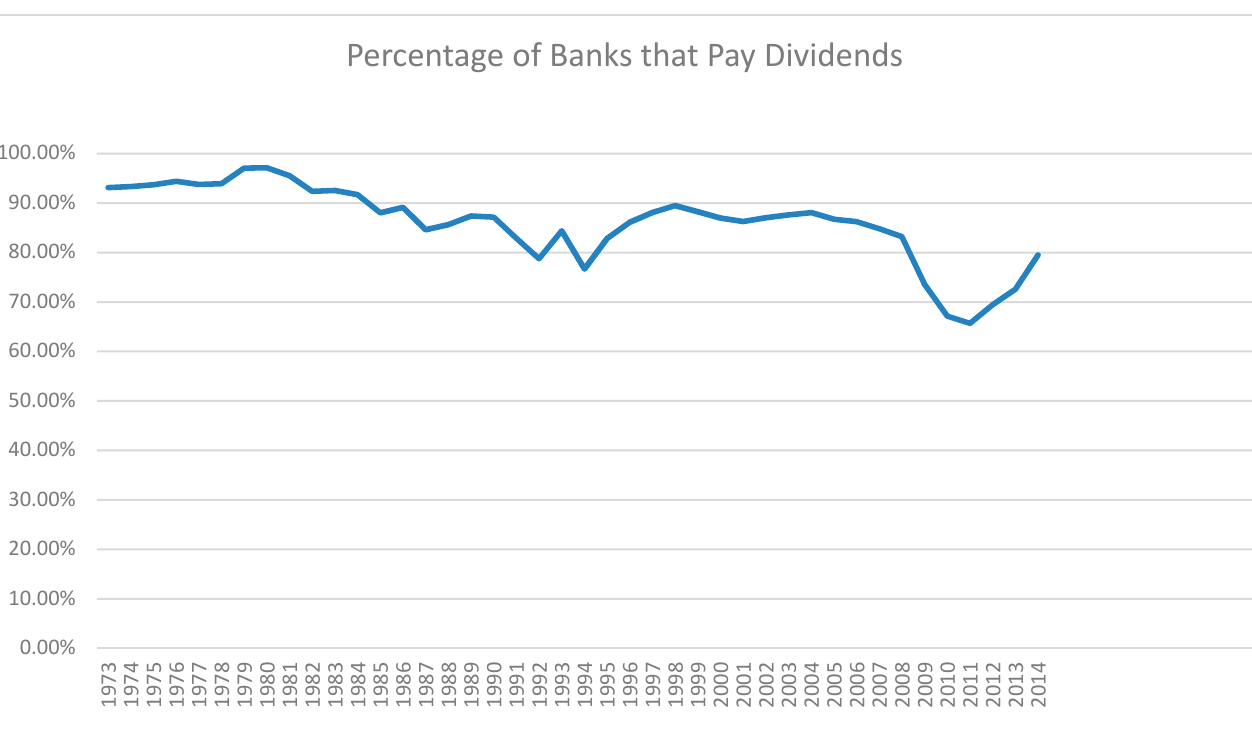
Figure 1. Actual percentage of banks that pay dividends for each year t.